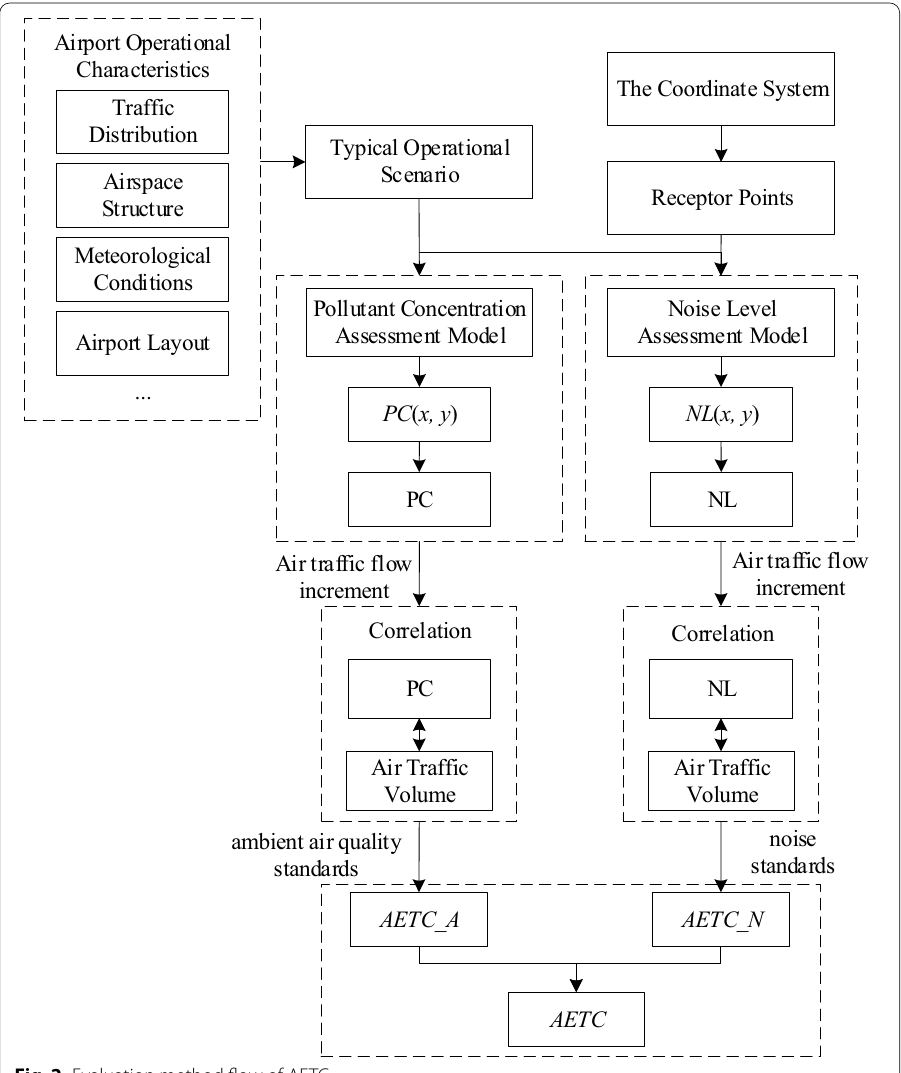
Fig. 2 Evaluation method flow of